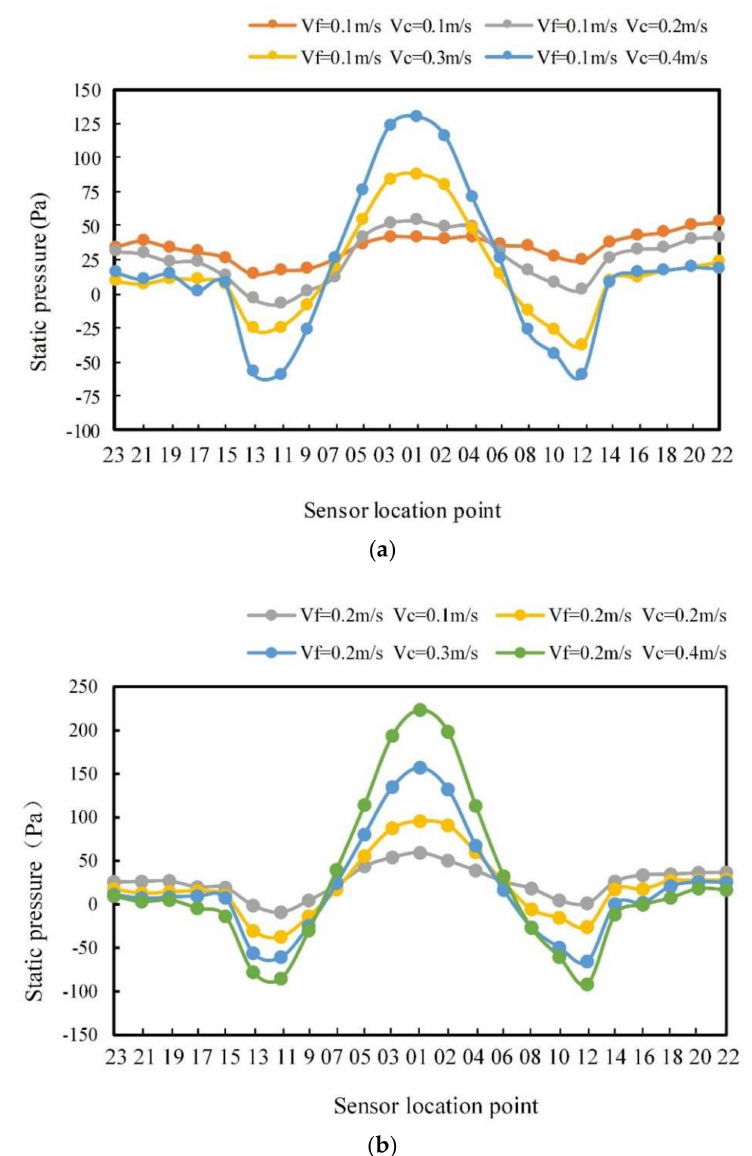
Figure 16. Sensor pressure distribution at di ff erent carrier speeds: ( a ) fluid velocity is 0.1 m / s, and ( b ) fluid velocity is 0.2 m /